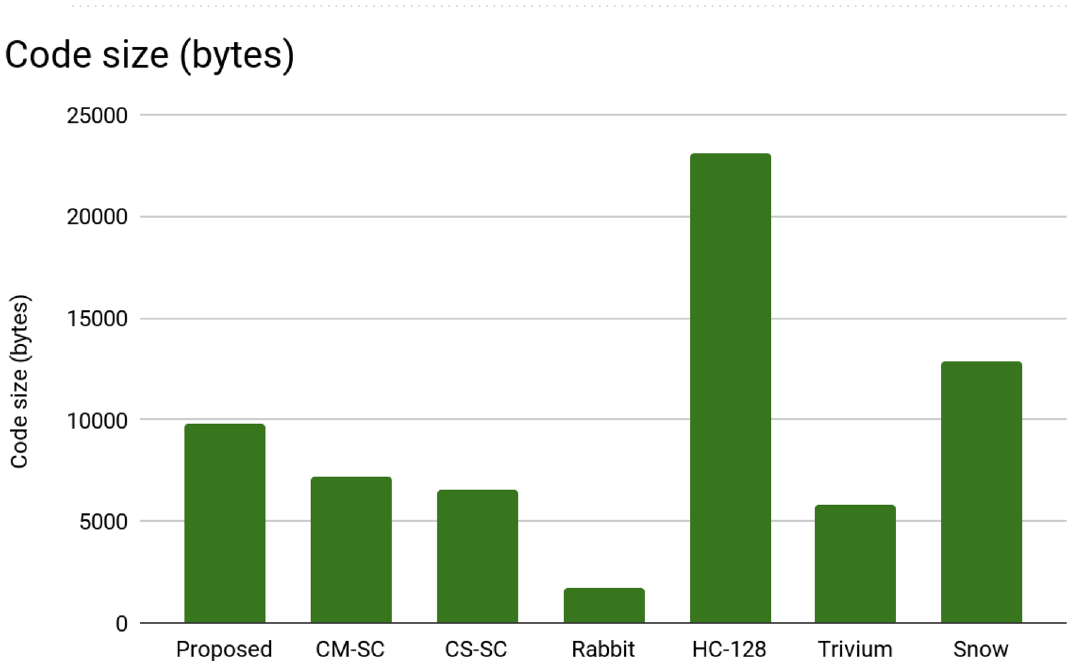
Figure 7. The comparison of the code size (ROM) in the proposed system with different encryption algorithms